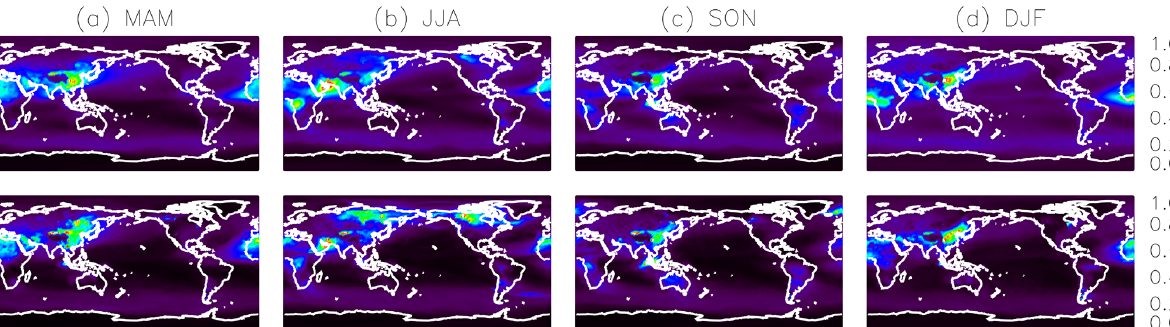
Figure 3. Mean (upper) and standard deviation (lower) of τ for free-run model from 2011 to 2015 in (a) March, April, and May, (b) June, July, and August, (c) September, October, and November, and (d) December, January, and